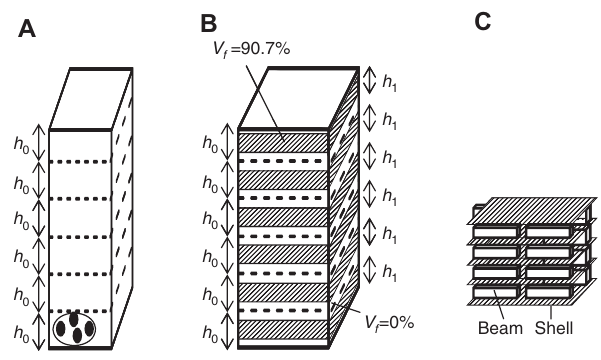
Figure 6 Basic concept of the quasi 3D model. (A) Composite laminate (six layers). (B) Intermediate. (c) Quasi 3D model.